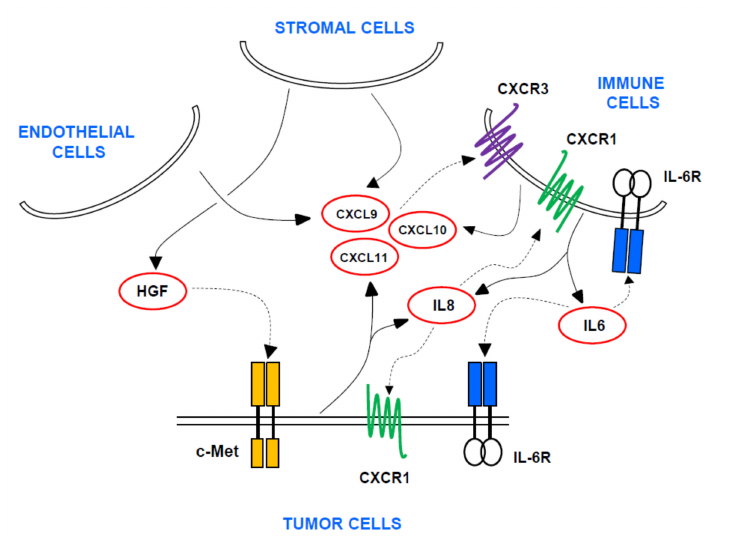
Figure 1. Scheme of biomarkers selected to study association with response, prognosis and toxicity in mRCC patients treated with sunitinib and/or pazopanib. The interactions between c-Met and HGF expression and activity of cytokines (IL-6, IL-8) and chemokines (CXCL9, CXCL10 and CXCL11) suggested by the literature, are shown with arrows. Tumor, endothelial, stromal and immune cells participate in this signaling